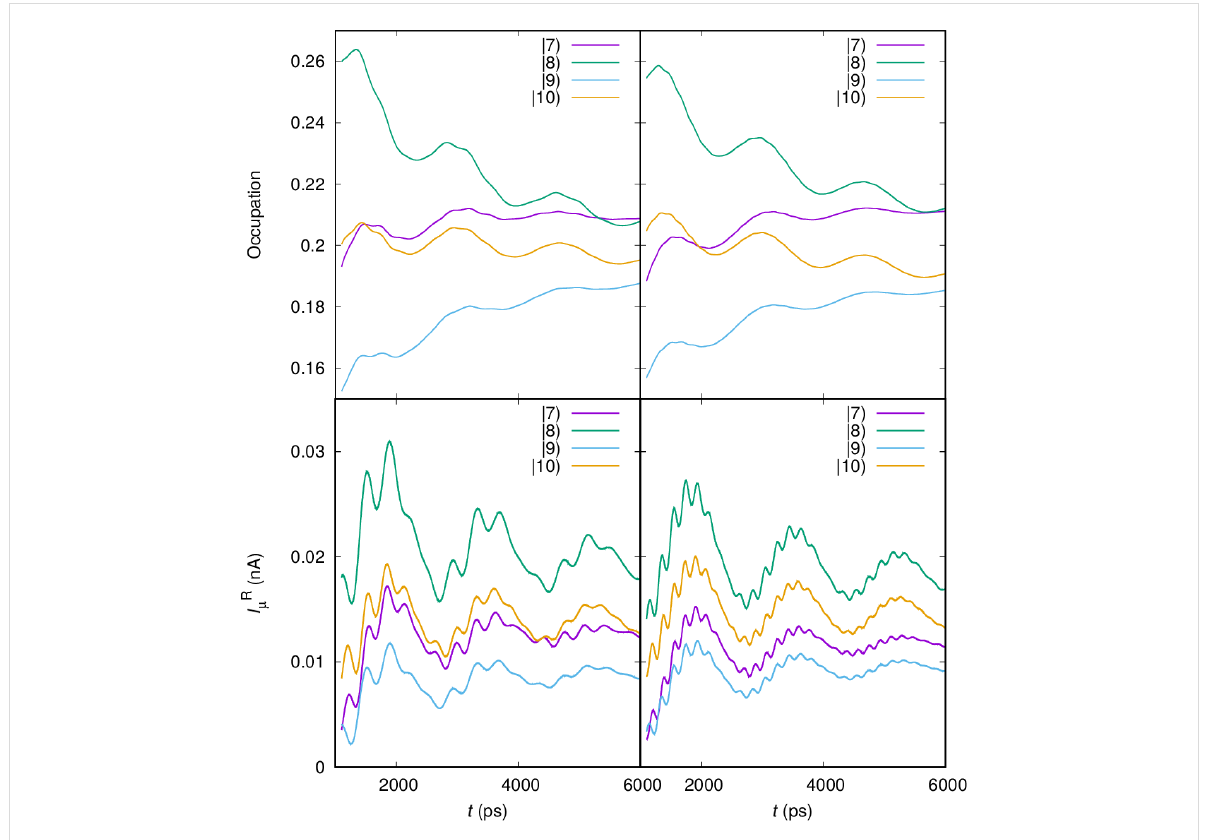
Figure 9: (Upper) The time-dependent partial current through the photon dressed one-electron states and in the bias window for electron–photon coupling g EM = 0.05 meV (left), and g EM = 0.10 (right). The partial current from the same states from the central system to the left lead for electron–photon coupling g EM = 0.05 meV (left), and g EM = 0.10 (right). According to Figure 2 states and have spin quantum number s z = − 1/2, but states